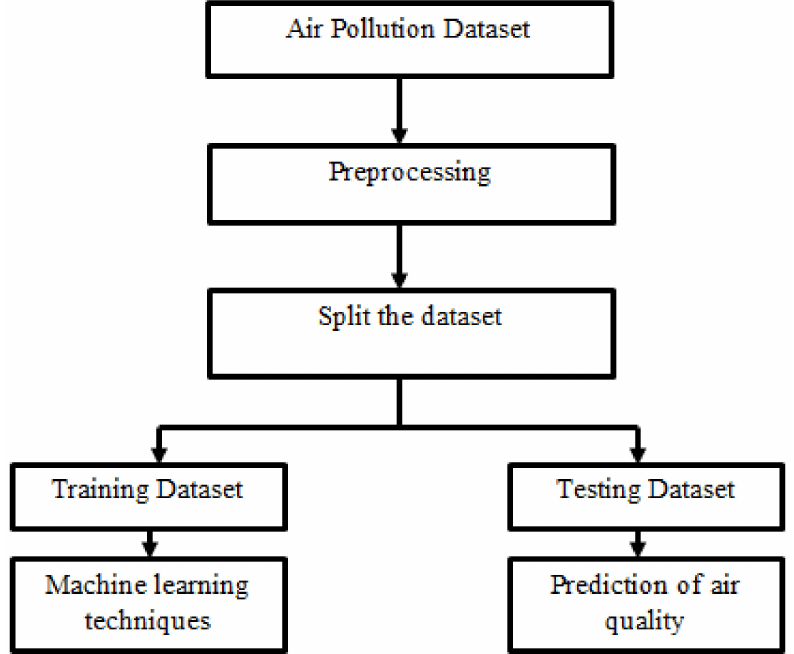
Figure 6. Flow diagram of air quality using ML